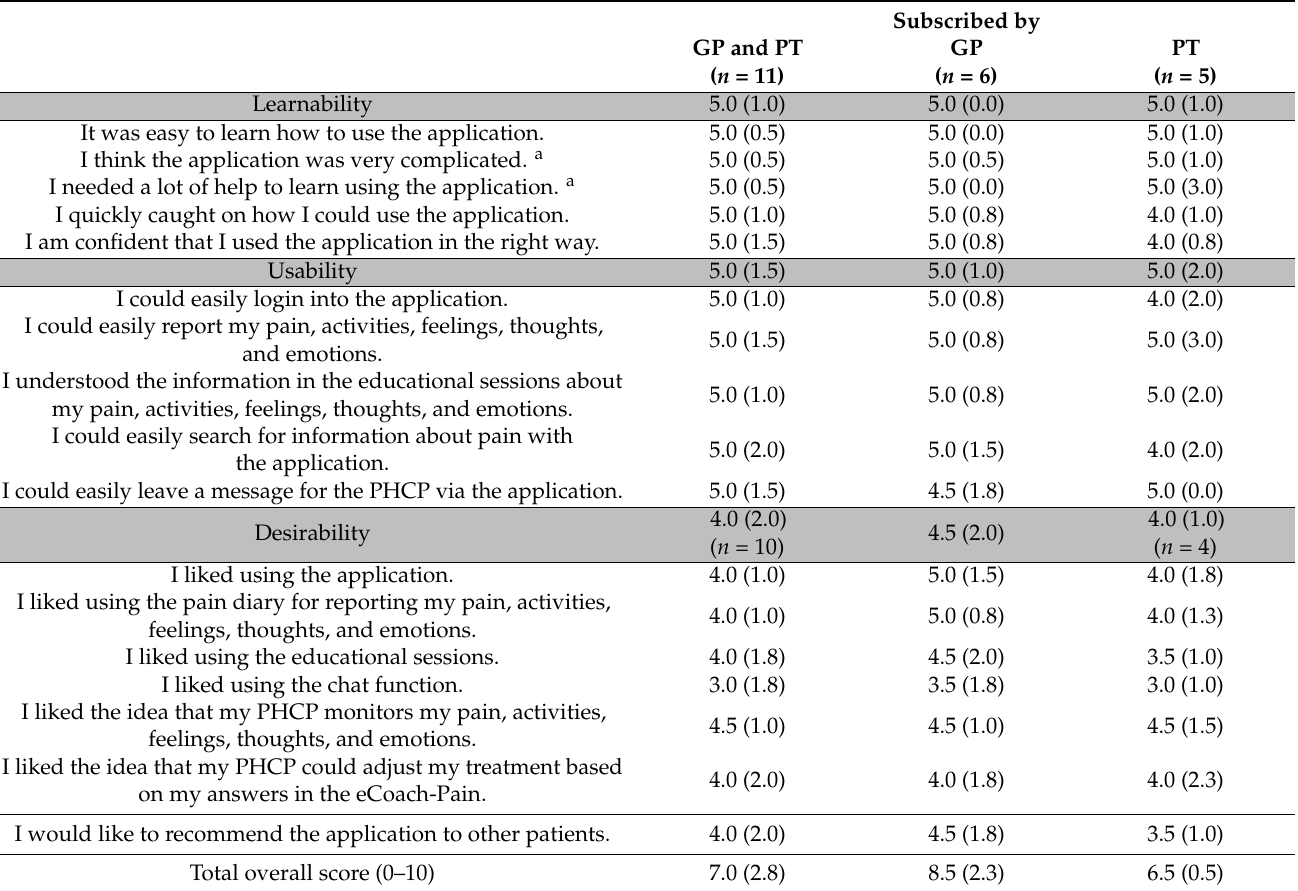
Table 2 presents the overall median score (GP and PT), as well as the median score of the categories, and items separately per discipline (by a GP or PT). The scores show that patients learned quickly how to manage the application (Median = 5.0, IQR = 1.0) and could easily use the different components of the eCoach-Pain (Median = 5.0, IQR = 1.5). The desirability was scored with a median score of 4.0, IQR = 2.0. The overall acceptance, rated by the question “I would like to recommend the application to other patients” was scored with a median of 4.0 (IQR = 2.0). Patients gave the eCoach-Pain a total overall score of 7.0 (IQR = 2.8) on a 0–10 Numeric Rating Scale. Patients subscribed by GPs ( n = 6) scored 5.0 (IQR = 0.0) for learnability, 5.0 (IQR = 1.0) for usability, and 4.5 (IQR = 2.0) for desirability, while patients subscribed by PTs ( n = 5) scored 5.0 (IQR = 1.0), 5.0 (IQR = 2.0), and 4.0 (IQR = 1.0), respectively. Table 2. Median (IQR) learnability, usability, and desirability scores for the total patient group, patients subscribed by GPs, and patients subscribed by PTs.*